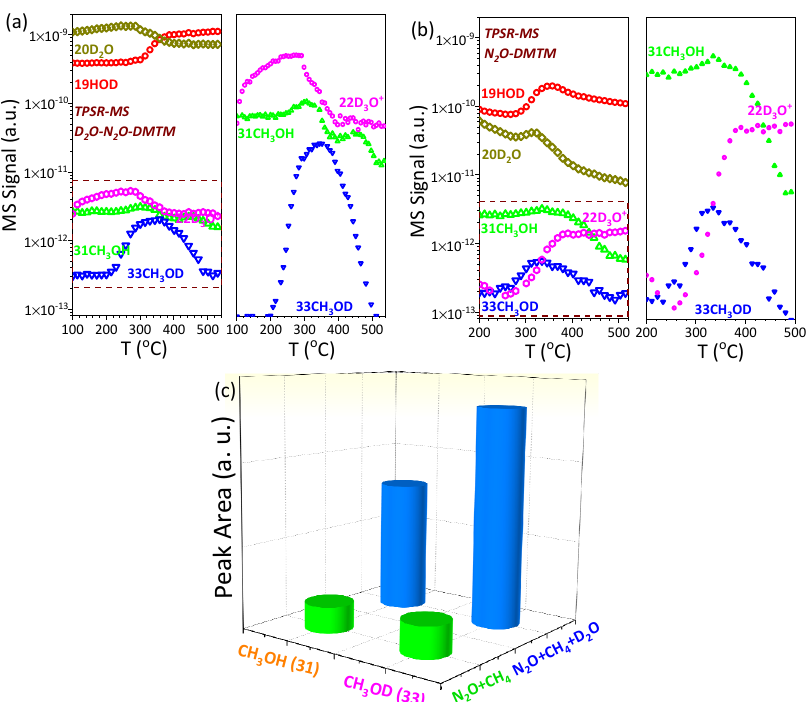
Figure 6. D 2 O isotopic tracer study based on temperature-programmed surface reaction (TPSR) over the Fe 0.60% Cu 0.68% -BEA. ( a ) D 2 O-mediated N 2 O DMTM and ( b ) N 2 O DMTM in the absence of D 2 O; as